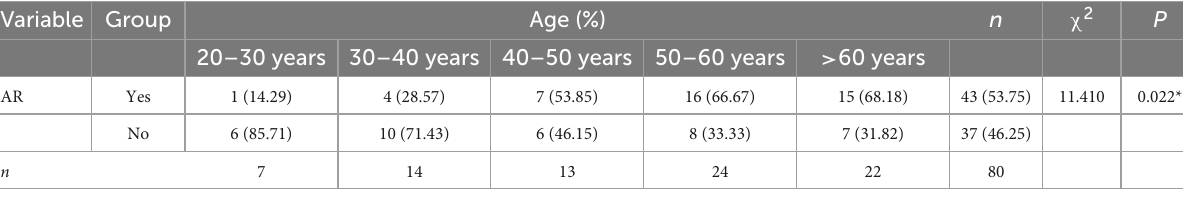
TABLE 5 The Chi-square test analysis of the relationship between different age segments and AR. Variable Group